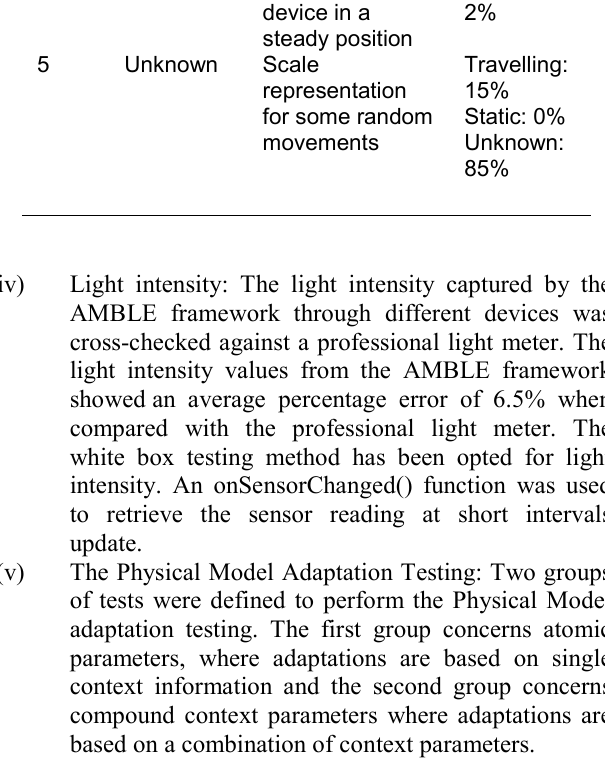
Table 1. Test cases for different activity performed by the learner